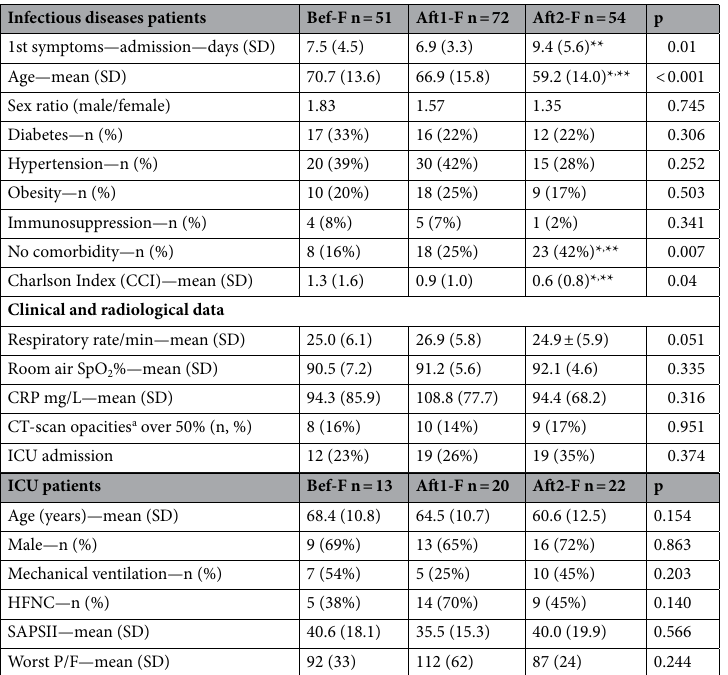
Table 2. Hospitalized patients in the infectious diseases and ICU departments: a three-periods assessment comparison. Bef-F: December 7th to 21st 2020, Aft1-F: January 24th to February 7th, Aft2-F: February 8th to 22nd. Comparison between groups by a non-parametric one-way ANOVA on ranks (Kruskal–Wallis test). Post hoc analysis (Fischer exact-test or Mann–Whitney U-test, if required): *p < 0.05 versus December **p < 0.05 versus January. a Typical Covid-19 related imaging such as subpleural ground-glass opacities and subsequent consolidations, small vessel or intralobular septum thickening